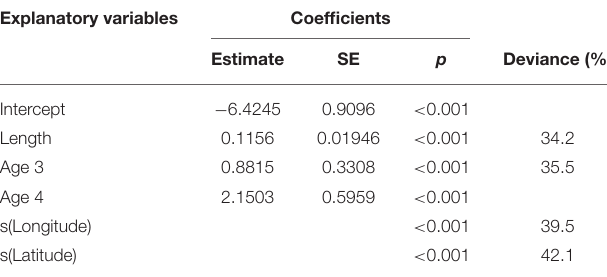
comparison between